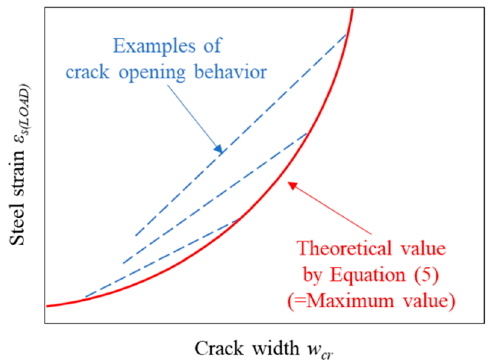
Figure 14. Steel strain–crack width relationship given by Equation